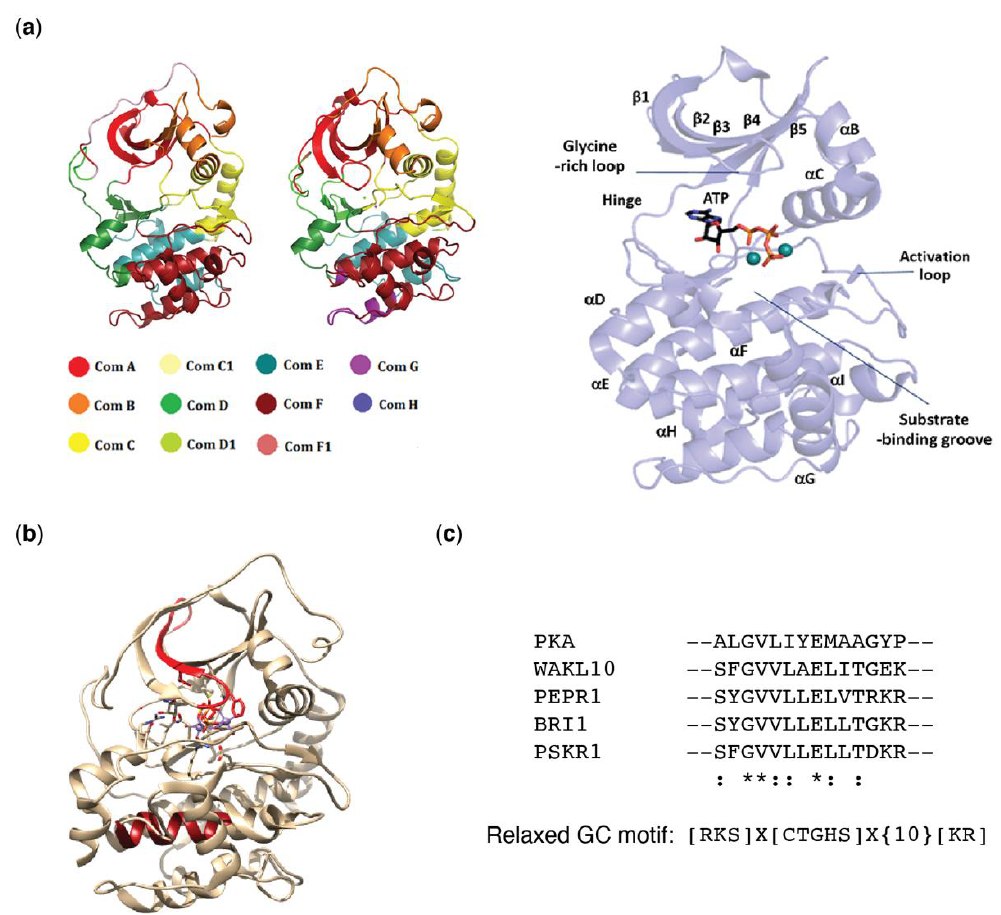
Figure 2. Protein kinase community maps and guanylate cyclase centers. ( a ) The different community maps present in protein kinases depicted using protein kinase A (PKA) (reproduced with permission from [148]). ( b ) Three-dimensional structure of Mus musculus PKA (Protein Data Bank entry: 3FJQ, 10.2210/pdb3FJQ/pdb) showing the ATP binding site, position of the guanylate cyclase center of diacylglycerol kinase 4 (DGK4; red) and the guanylate cyclase center of the receptor like kinases (RLK; dark red). ( c ) Alignment of the RLK guanylate cyclase center with the corresponding region in M. musculus PKA with amino acids that are identical indicated by asterisk(*), and those that are similar by colon (:).